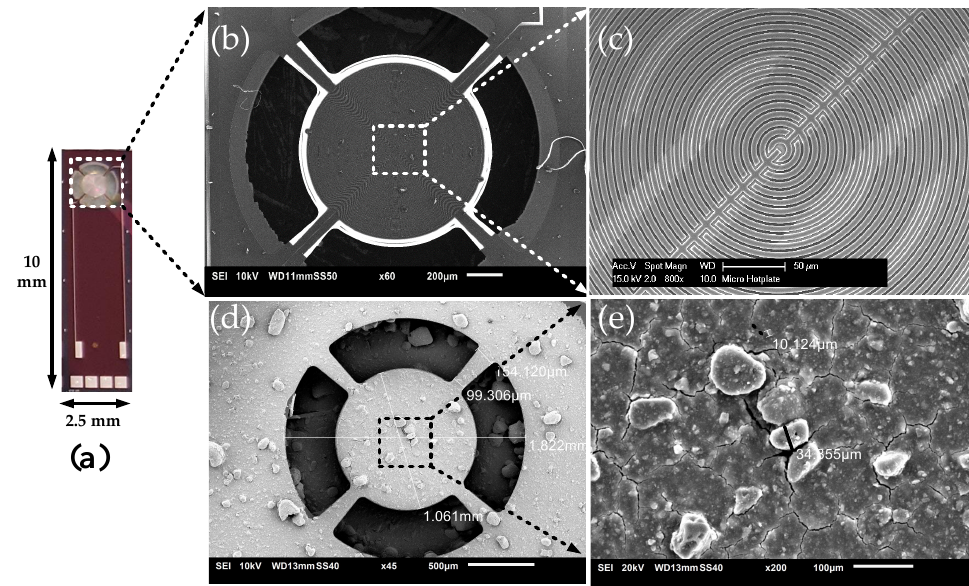
Figure 4. ( a ) Fabricated device. ( b ) SEM image of the suspended microhotplate with capacitor IDE. ( c ) A close-up image showing the active area of the device. ( d ) ZIF-8 MOF-coated device ( e ) A close-up image of ZIF-8 MOF on top of the